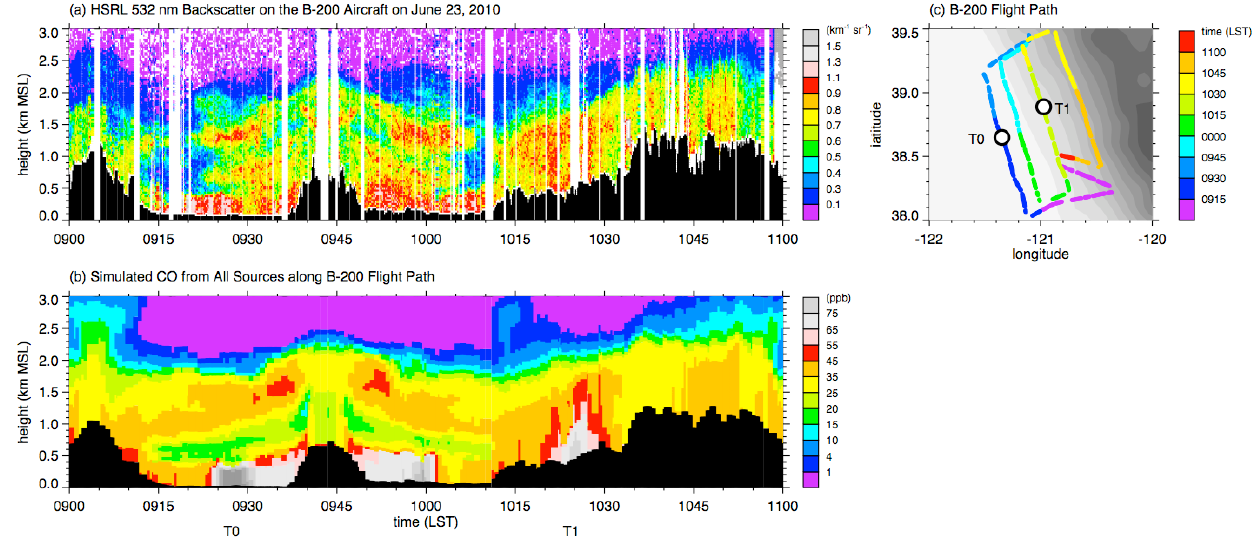
Figure 18. Observed and simulated quantities along the B-200 flight during the morning of June 23 including (a) observed backscatter and (b) simulated CO from all sources. (c) B200 flight path divided into 15-min segments denoted by colors and gray shading is topography. White areas in (a) denote missing data or negative backscatter values while black areas in (a) and (b) denote topography.